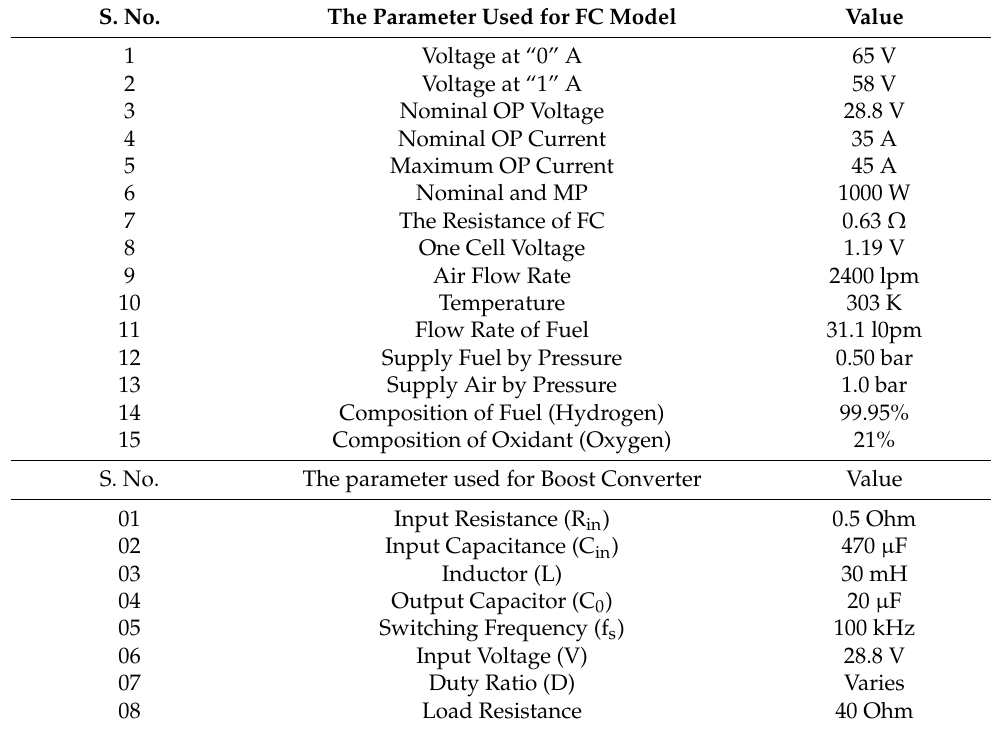
Figure 22. Subsystem of fuzzy logic controller. Table 2. Specifications of FC